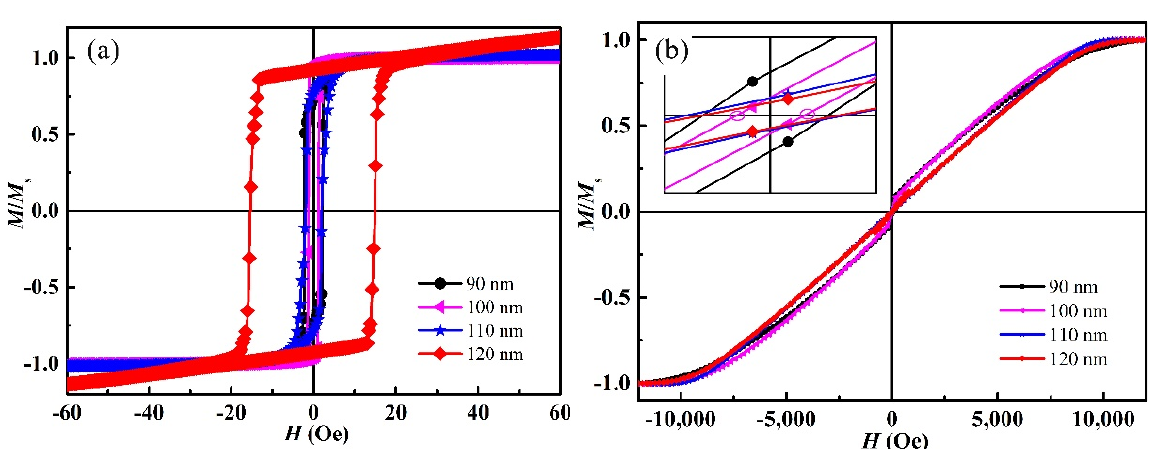
Figure 2. The magnetic hysteresis ( M-H ) loops of NiFe thin films with thickness from 90 to 120 nm: ( a ) the in-plane magnetic hysteresis loops, ( b ) the out-of-plane magnetic hysteresis loop.